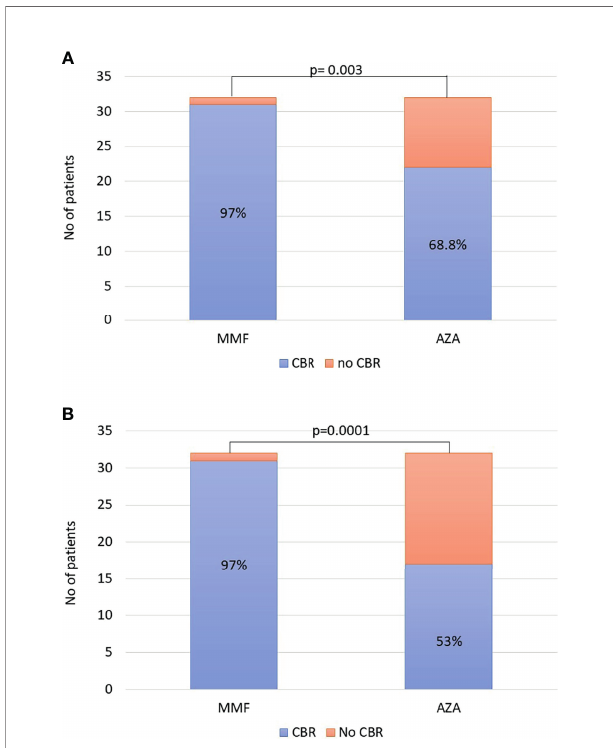
FIGURE 1 | (A) Intention-to-treat analysis: complete biochemical response (CBR) at last follow-up was signi fi cantly higher in the mycophenolate mofetil (MMF) group [31/32 (97%)] compared to that in the azathioprine (AZA) group [22/32 (68.8%); p = 0.003]. (B) At the end of follow-up, the overall ef fi cacy of